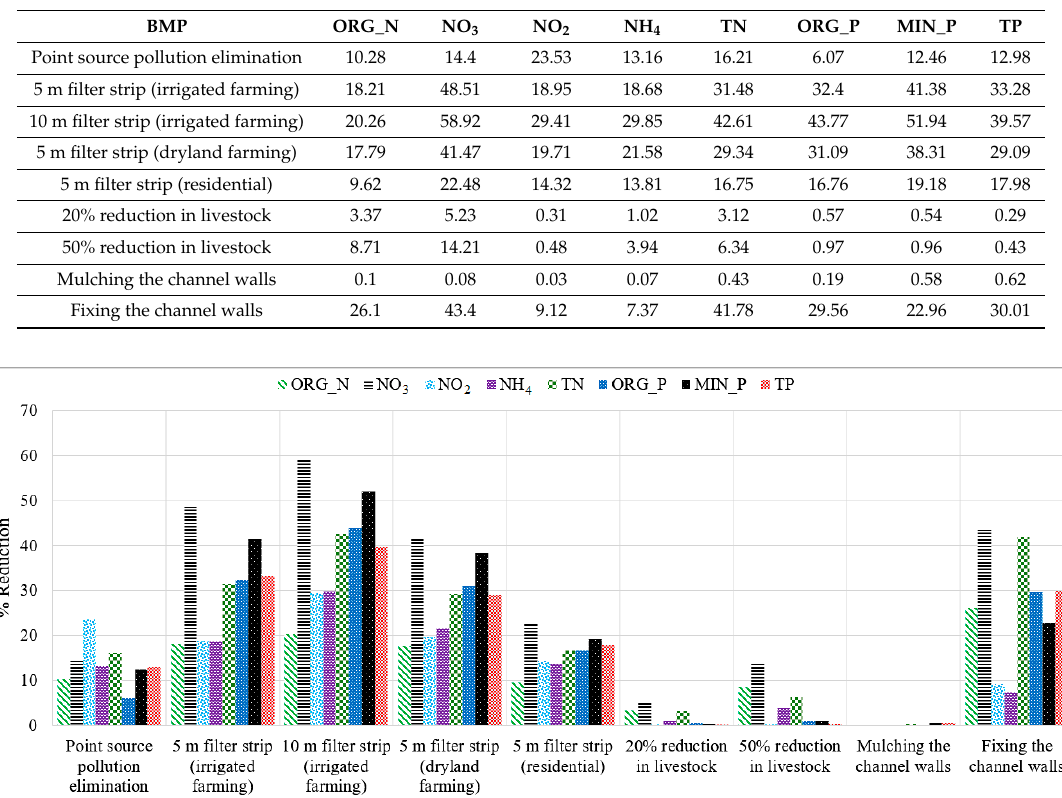
Table 3. Pollution loads reduction after implementation (%) of Best Management Practices (BMPs).